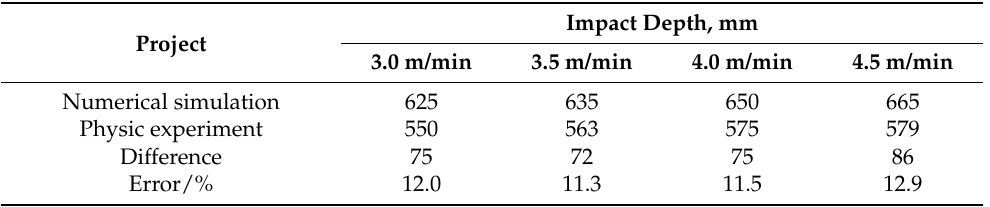
Table 2. Comparison of the impact depth under different casting